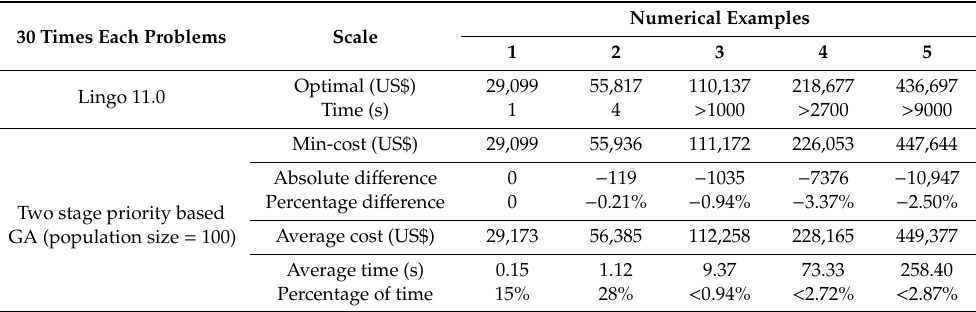
Table 9. Comparison with Lingo in Experiment